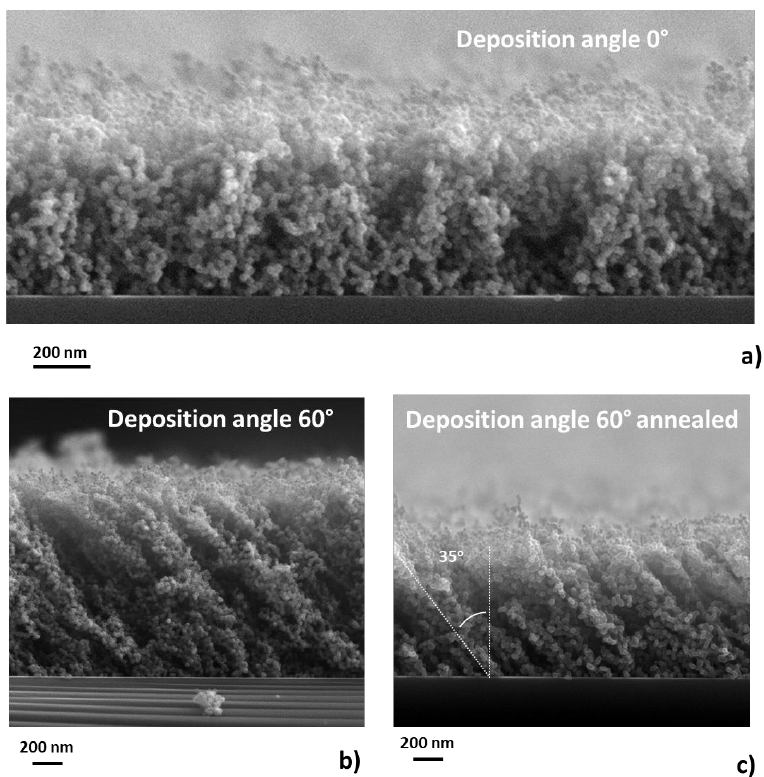
Figure 7. Top-view SEM images of growing Ti nanoparticle films deposited at ( a ) zero tilting angle and ( b ) tilting angle of 60°.